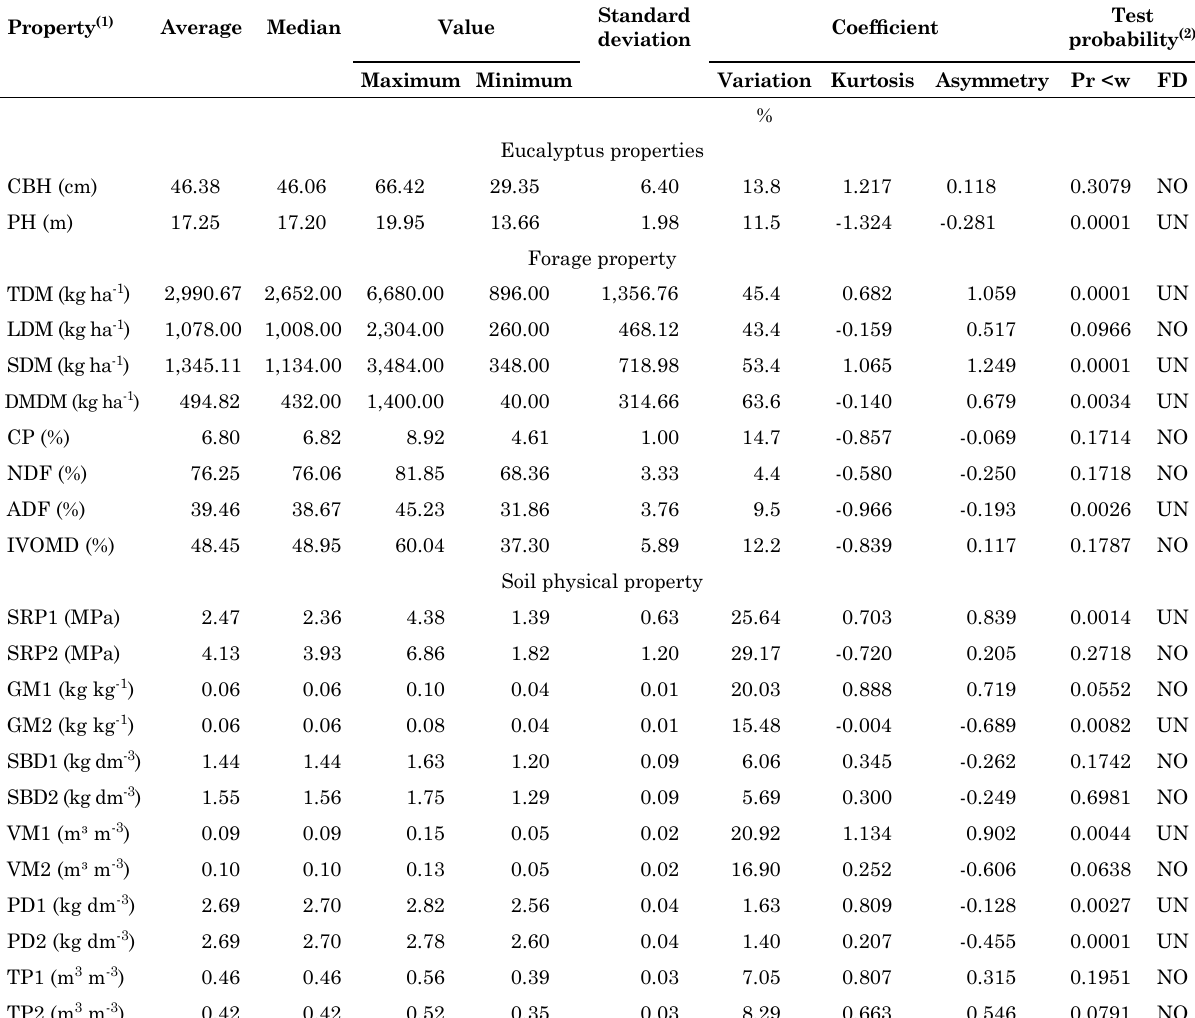
Table 1. Initial descriptive analysis of dendrometric properties of Eucalyptus urograndis , yield and bromatological properties of forage, and physical properties of Quartzipsamment (Entisol) soil in a silvopastoral system in Ribas do Rio Pardo, MS,